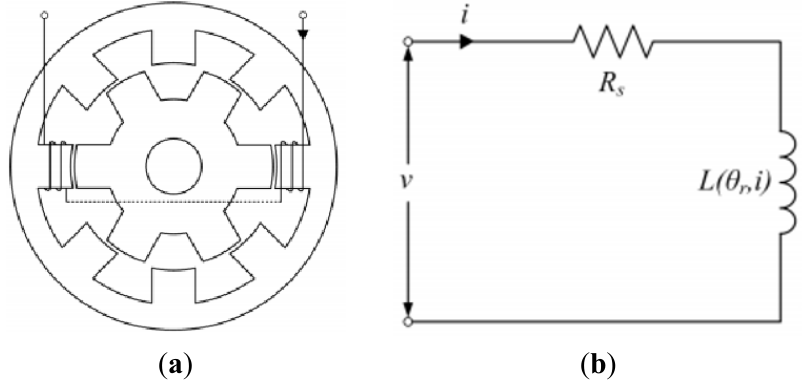
Figure 1. Four phase 8/6-pole Switched Reluctance Generator (SRG): ( a ) cross-sectional profile; ( b ) equivalent circuit of one phase